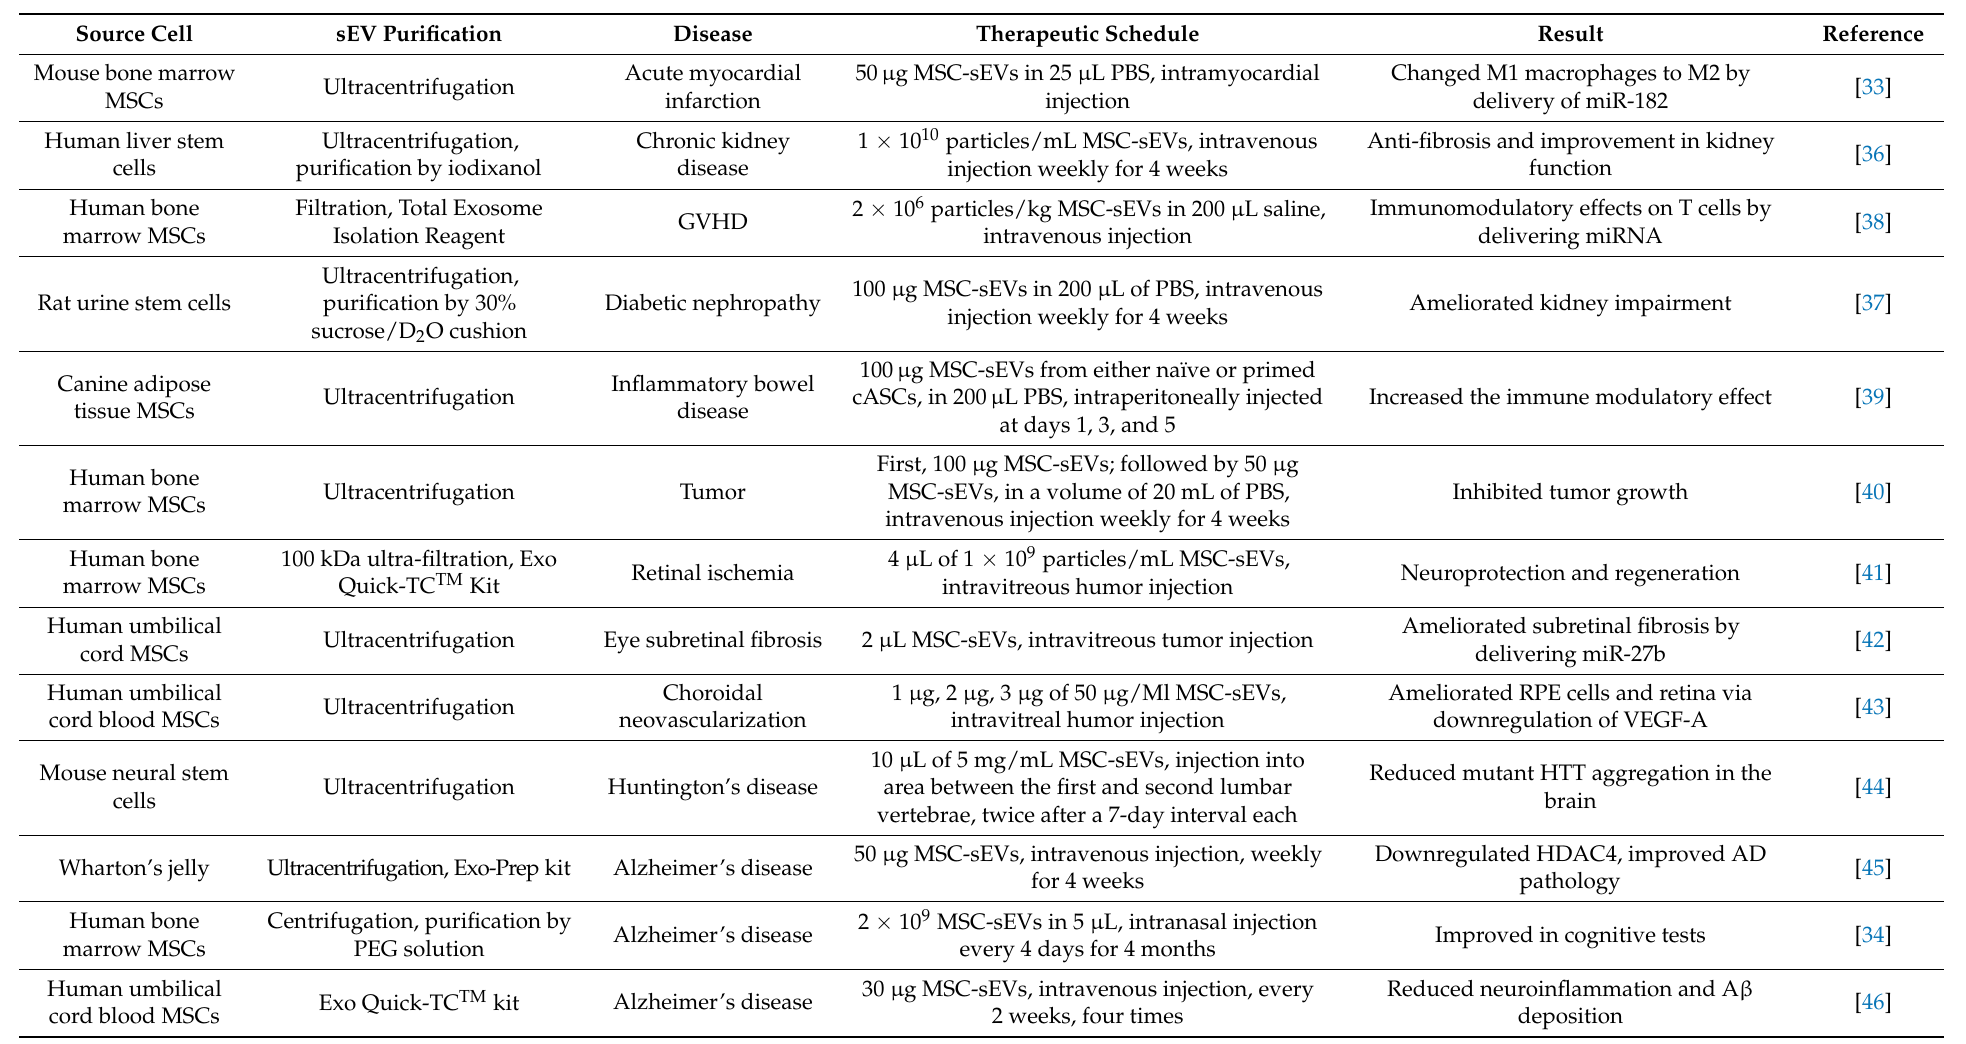
Table 2. Therapeutics using stem cell-derived naïve